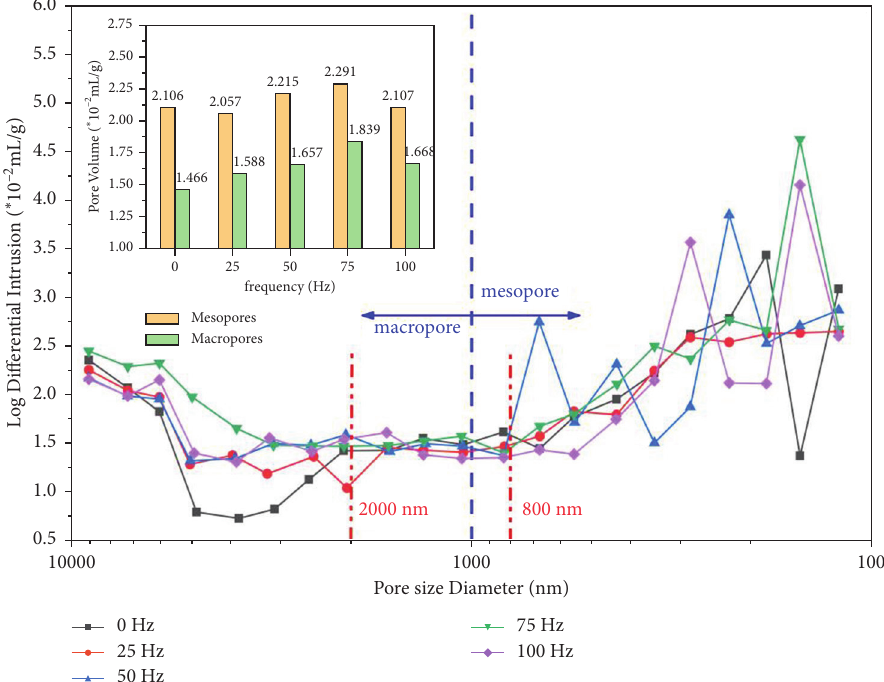
Figure 4: PSD and TPV of macropores and